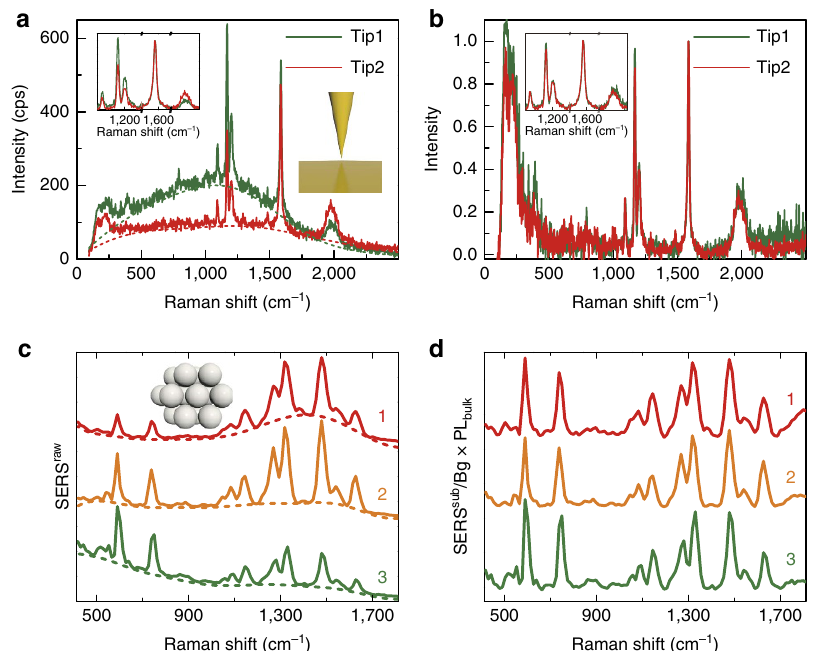
Figure 5 | TERS signal and SERS spectra of silver nanoaggregates before and after correction. ( a ) TERS raw spectra for a gold tip near a flat gold surface, the latter covered by 4-chlorophenyl isocyanide molecules (solid lines), and corresponding background Bg (dashed lines). The two sets of spectra are obtained using two different tips. The inset shows the background-subtracted TERS sub spectra in the region 1,000–2,100cm (cid:2) 1 , which were further normalized to the Raman peak at 1,586cm (cid:2) 1 . ( b ) Corrected TERS spectra obtained from the spectra in a by subtracting the background Bg and processing the resulting TERS sub according to TERS sub (cid:3) PL bulk /Bg, which were further normalized with the Raman peak at 1,586cm (cid:2) 1 . The inset shows the enlarged corrected TERS spectra in the region 1,000–2,100cm (cid:2) 1 . ( c ) Three typical SERS raw spectra of Rhodamine 6G molecules adsorbed on different silver nanoaggregates (solid lines), and corresponding background (dashed lines). ( d ) Corrected SERS spectra obtained from the spectra in c by subtracting the background Bg and processing the resulting SERS sub as SERS sub (cid:3) PL bulk /Bg, which was further normalized to the Raman peak at 1,545cm (cid:2) 1